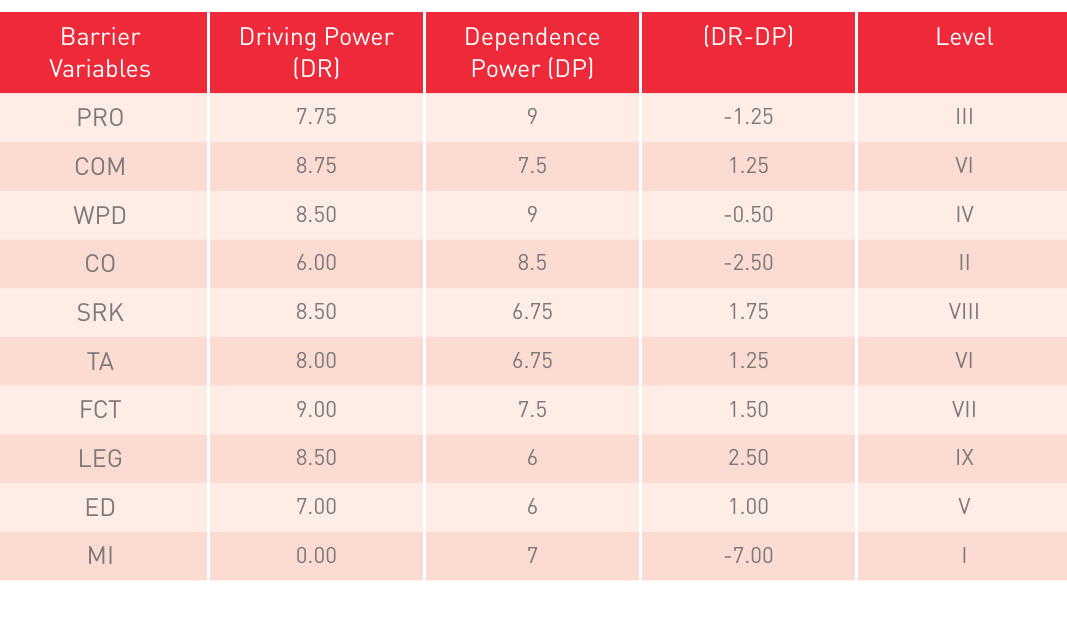
Table 9. Table 9. Effectiveness and Ranking of Variables